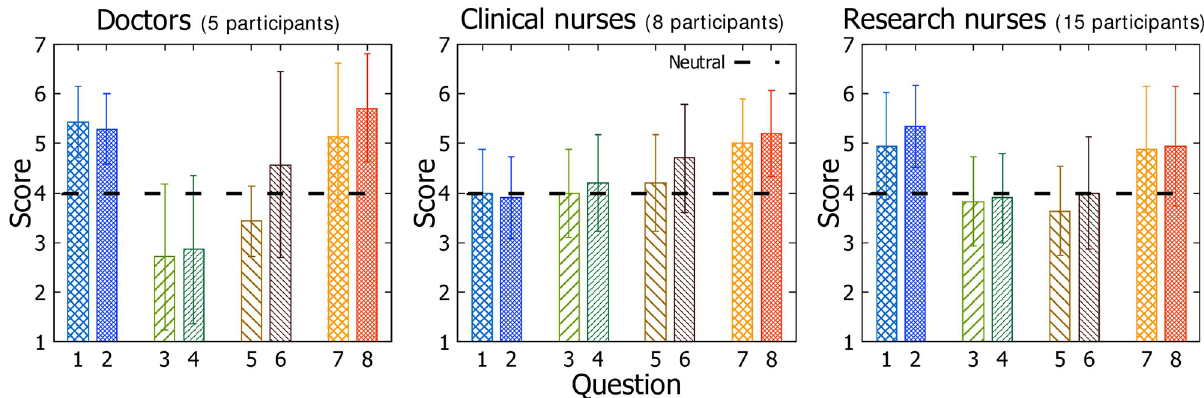
Fig 5. Scores (Likert-scale) for questions in the pre-study with 5 doctors, 8 clinical nurses, and 15 research nurses. Score 4 shows “neutral.”